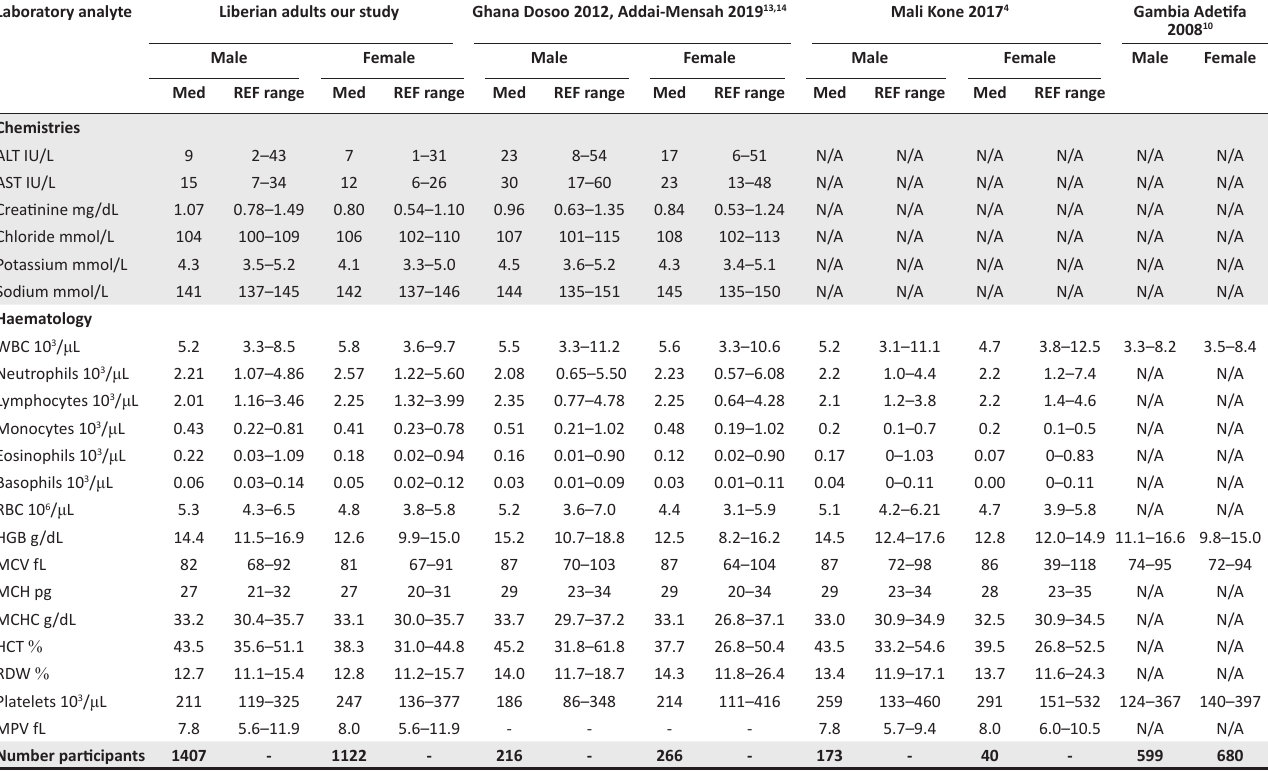
TABLE 4: Comparisons of adult Liberian reference ranges with other adult African countries reference ranges, Monrovia, Liberia 2015–2017. Laboratory